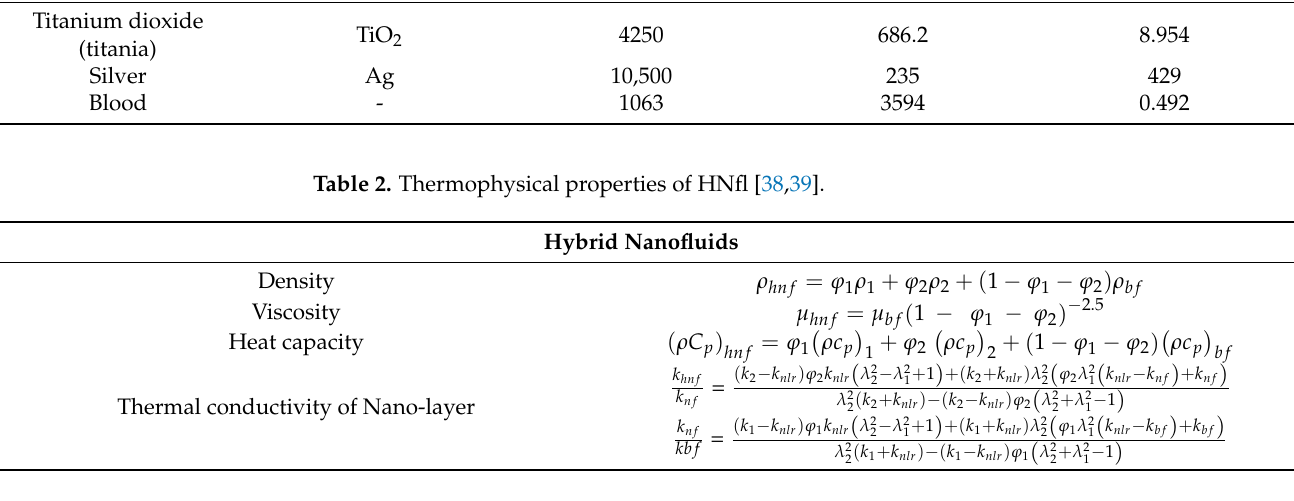
Table 1. Description of the thermophysical properties of nanoparticles and base fluid [24]. Nanoparticles and Molecular Formula Base Fluid